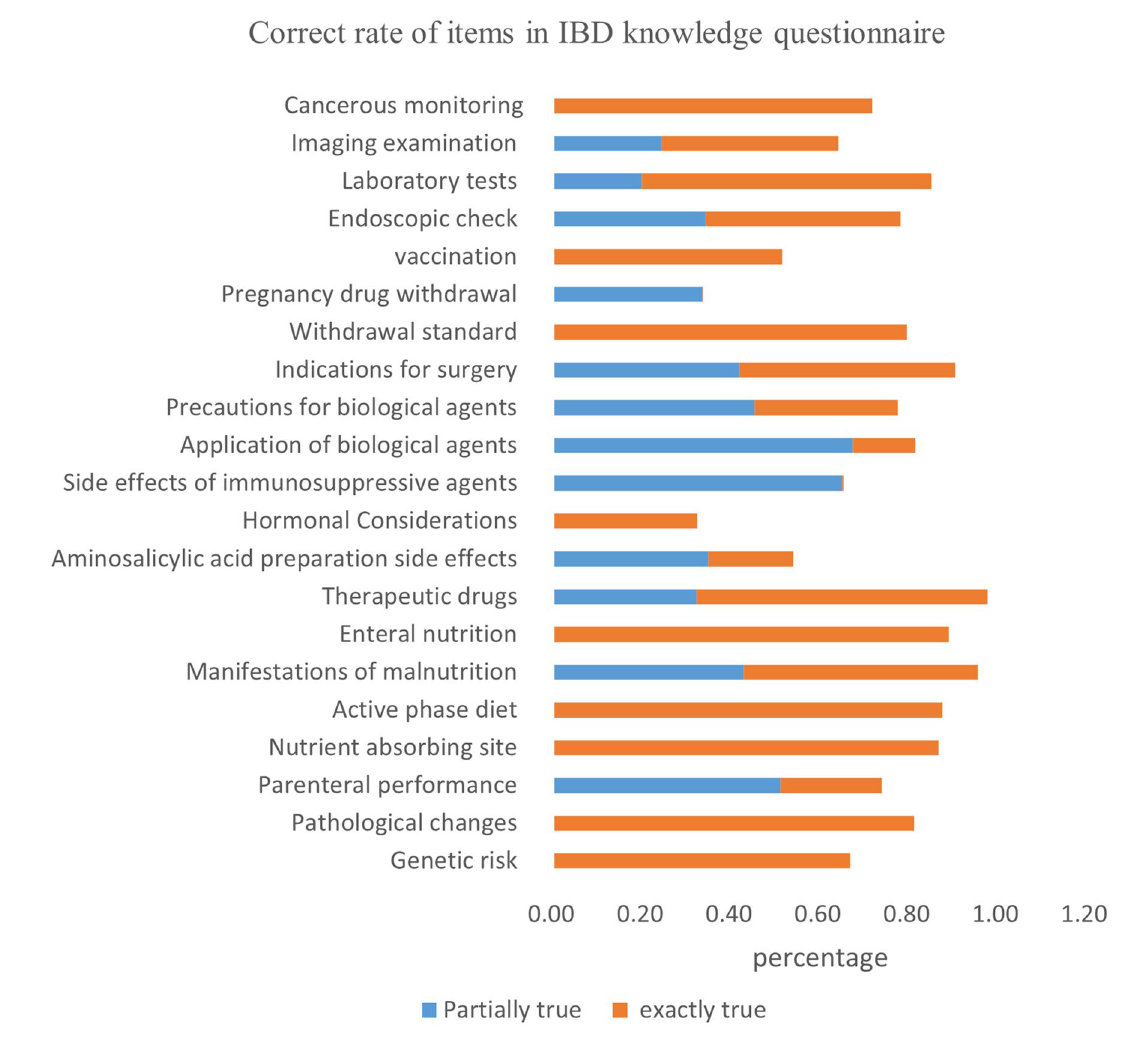
Figure 1. Correct response rate of patients to each item of the IBD knowledge questionnaire.